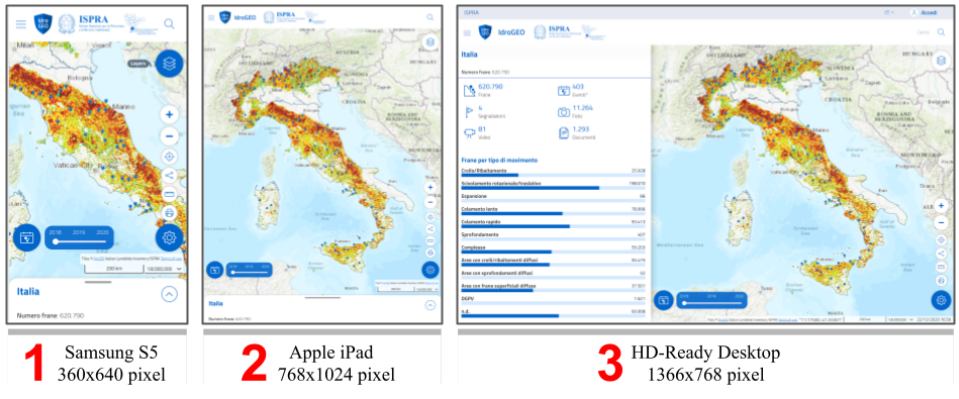
Figure 7. Map tools and informative panels placement for different resolutions and devices. Map tools and panels are arranged as depicted in Figure 8 based on the mobile screen: the same arrangement is maintained in both the typical tablet portrait and desktop landscape resolutions, where the contextual data and tools are kept visible in the left side panel (Figure 7).